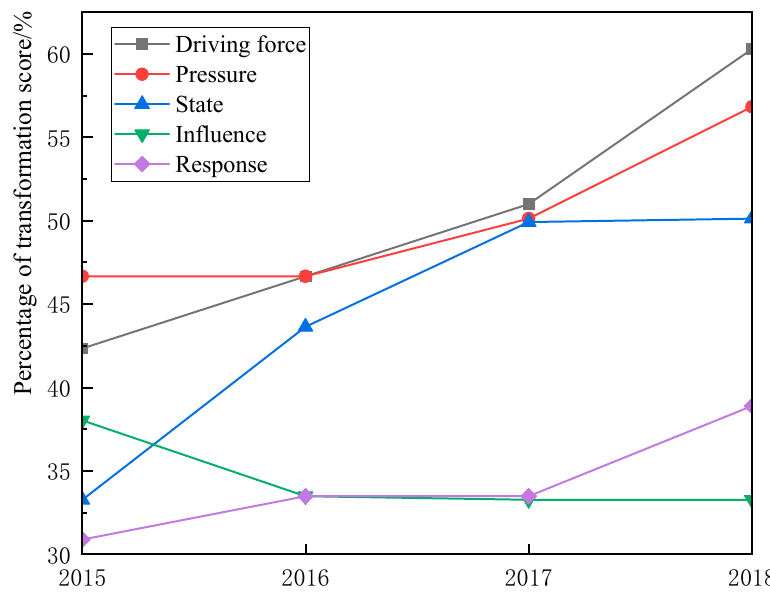
Figure 9. Percentage of subsystem scores for urban construction transformation of coal-energy cities.